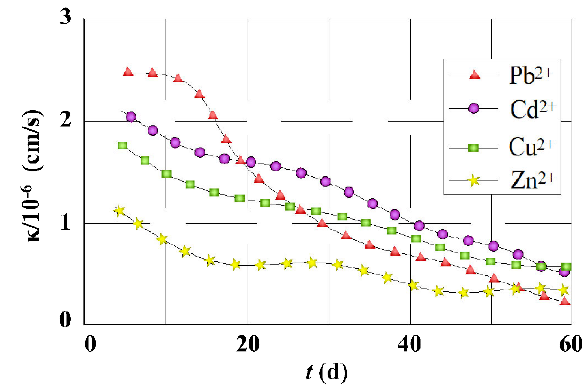
Fig. 7. The comparisons of intrusion performance of heavy metal